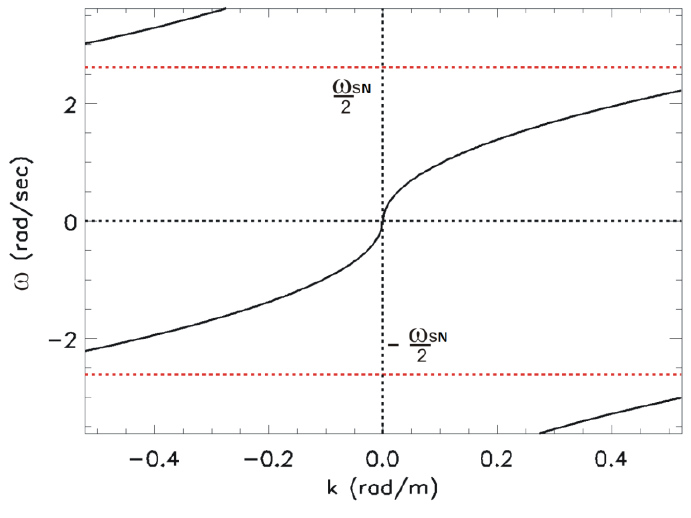
),(  obtained form the spectrum of N